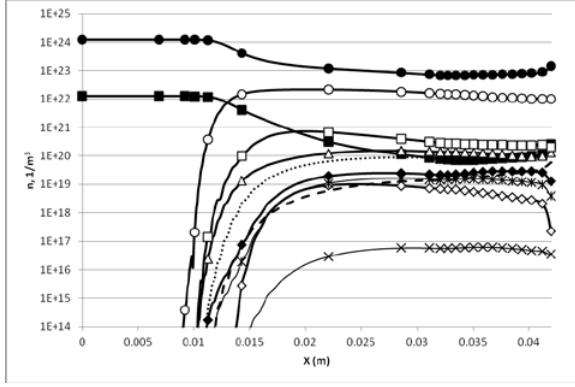
Figure 8 . Profiles of number densities of the main species along symmetry axis for model 2. Notations are the same as in Fig.